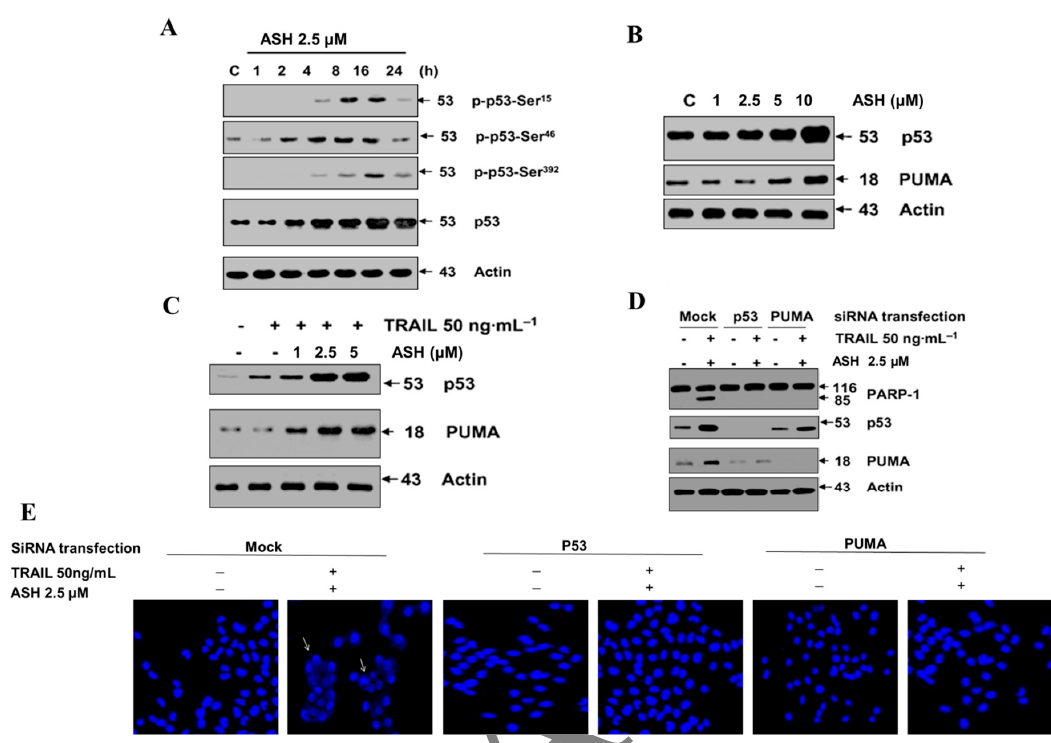
Figure 6. ASH promotes phosphorylation and accumulation of p53 and increases PUMA expression. ( A ) HepG2 cells were exposed to 2.5 μ M ASH for 1, 2, 4, 8, 16 and 24 h, phosphorylation of p53 at Ser46, Ser392 and Ser15 residues were analyzed by Western blotting assay). Control group received an equal amount of vehicle (0.1% DMSO). ( B ) HepG2 cells were exposed to 1, 2.5, 5, 10 μ M ASH for 12 h, the expression of PUMA and p53 protein were analyzed by western blotting assay. ( C ) HepG2 cells were exposed to 1, 2.5, 5 μ M ASH with or without 50 ng/mL TRAIL for 12 h, PUMA and p53 protein expression were analyzed by western blotting assay. ( D ) Small interfering RNA (siRNA) has been used to specifically silence PUMA or p53; 48 hours after transfection, the HepG2 cells were exposed to 5 μ M ASH with or without 50 ng/mL TRAIL for 12 h. The cleavage of PARP-1 and the expression of p53 and PUMA were analyzed via Western blotting assay. ( E ) DAPI staining test was performed to assess the apoptosis-inducing e ff ects of ASH and TRAIL combination therapy in HepG2 cells after P53 or PUMA siRNA transfection. Chromatin condensation of the tumor cells was shown with white arrows observed by fluorescence microscopy (Magnification ×